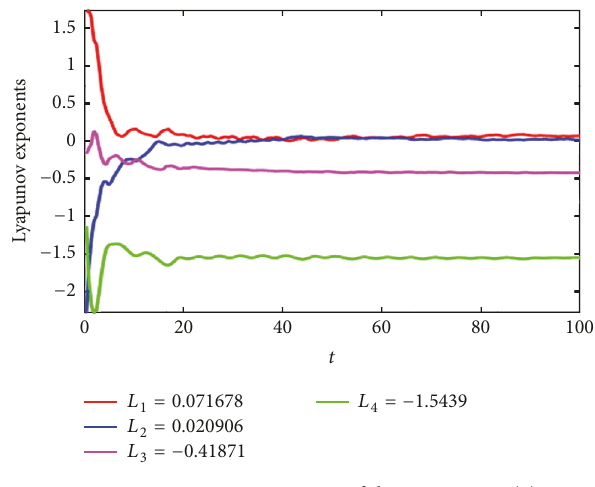
Figure 8: Lyapunov exponents of the new system